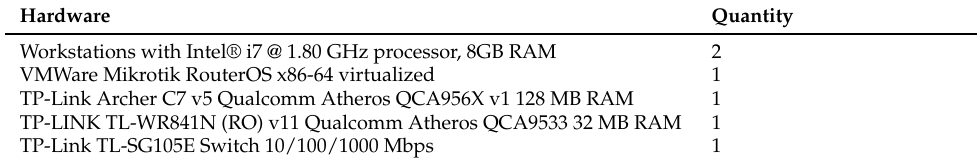
Table 3. Network topologies HW